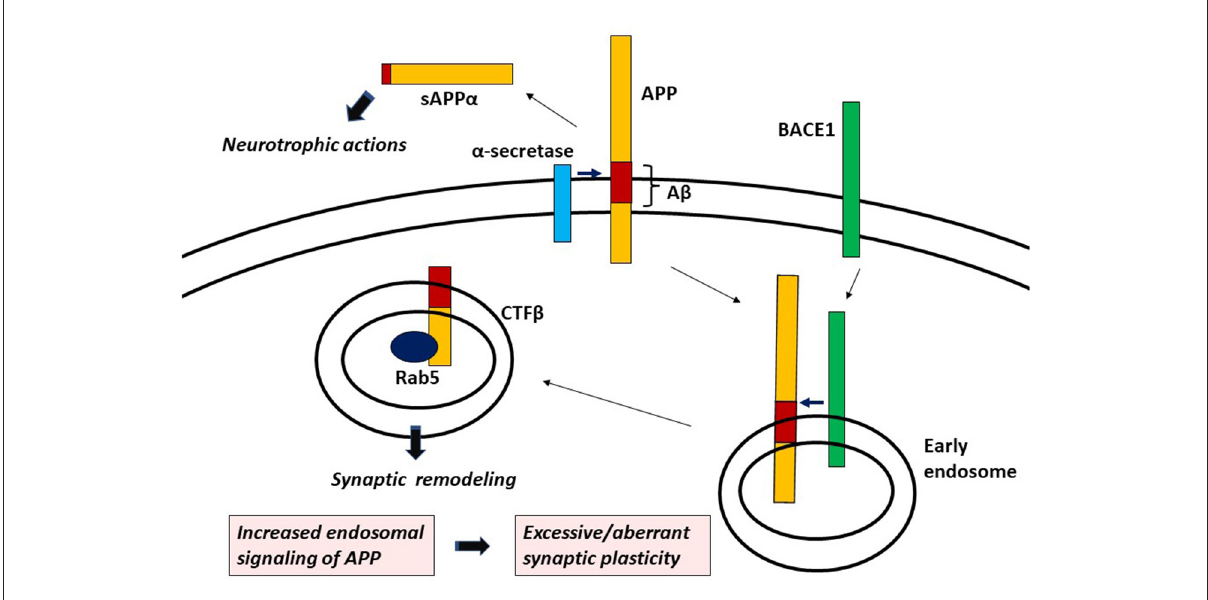
FIGURE1 APP signaling leading to aberrant/excessive synaptic